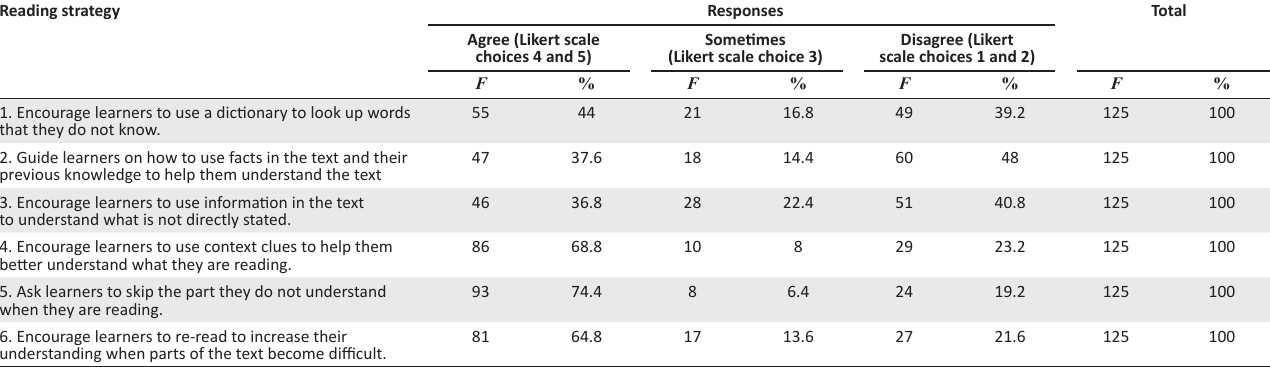
TABLE 2: During-reading strategies. Reading